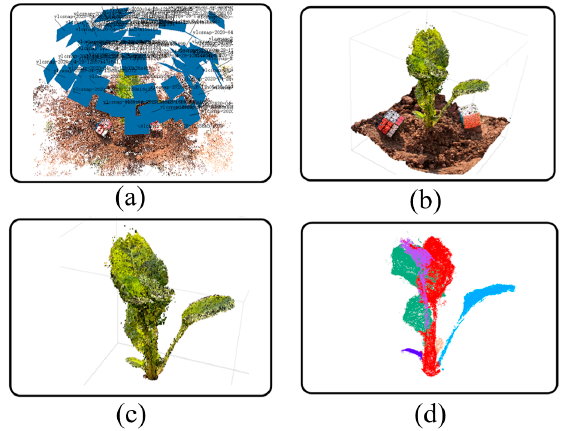
Figure 4. The process of generating a point cloud. ( a ) SfM reconstruction, ( b ) dense point cloud, ( c ) point cloud after ground removal and filtering, ( d ) point cloud segmentation.